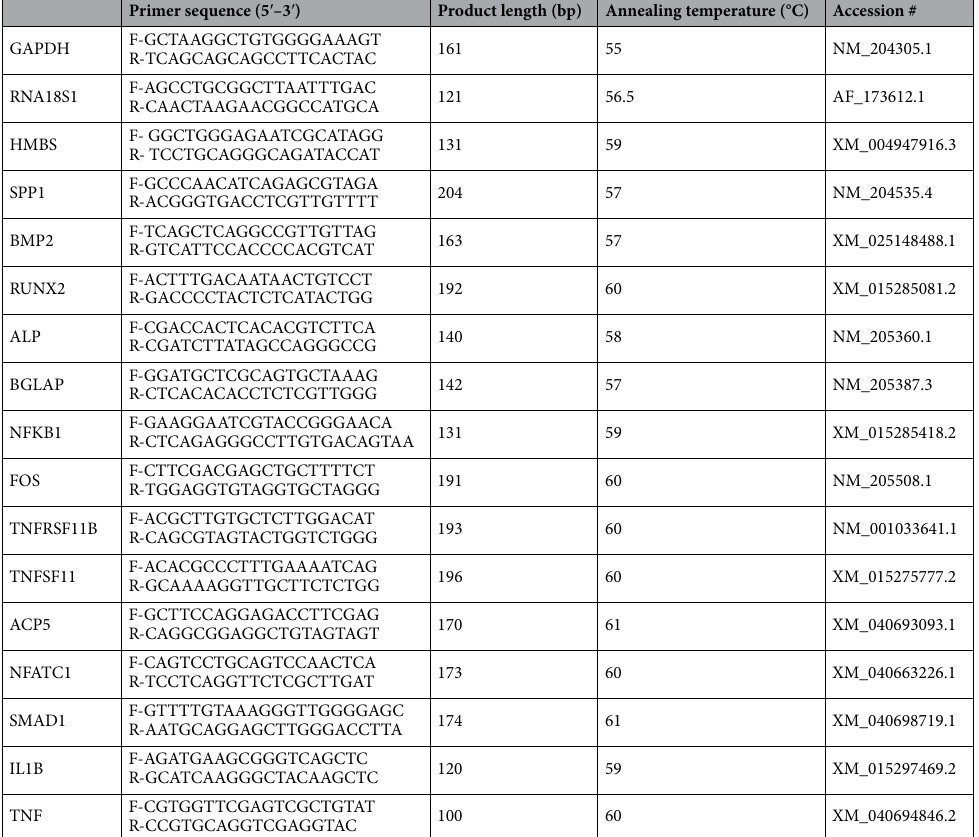
Table 4. Nucleotide sequences of the primers used for real-time RT-PCR. 1 GAPDH: glyceraldehyde- 3-phosphate dehydrogenase; HMBS: hydroxymethylbilane synthase; RNA18S1: RNA, 18S ribosomal 1; ACP5: TRAP, acid phosphatase 5, tartrate resistant; TNFSF11: RANKL,TNF superfamily member 11;